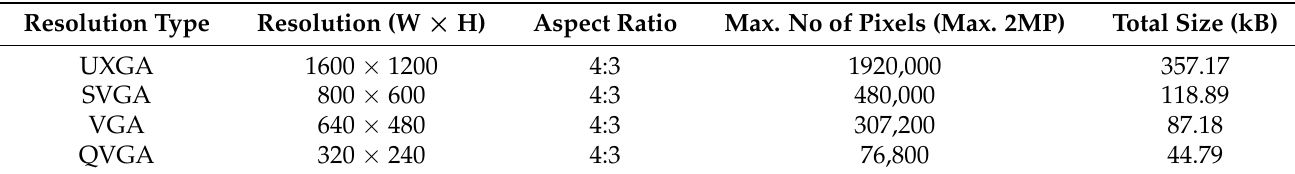
Table 1. Image details with their resolution, aspect ratio, total number of pixels and their sizes in (kB) when stored in JPG format.